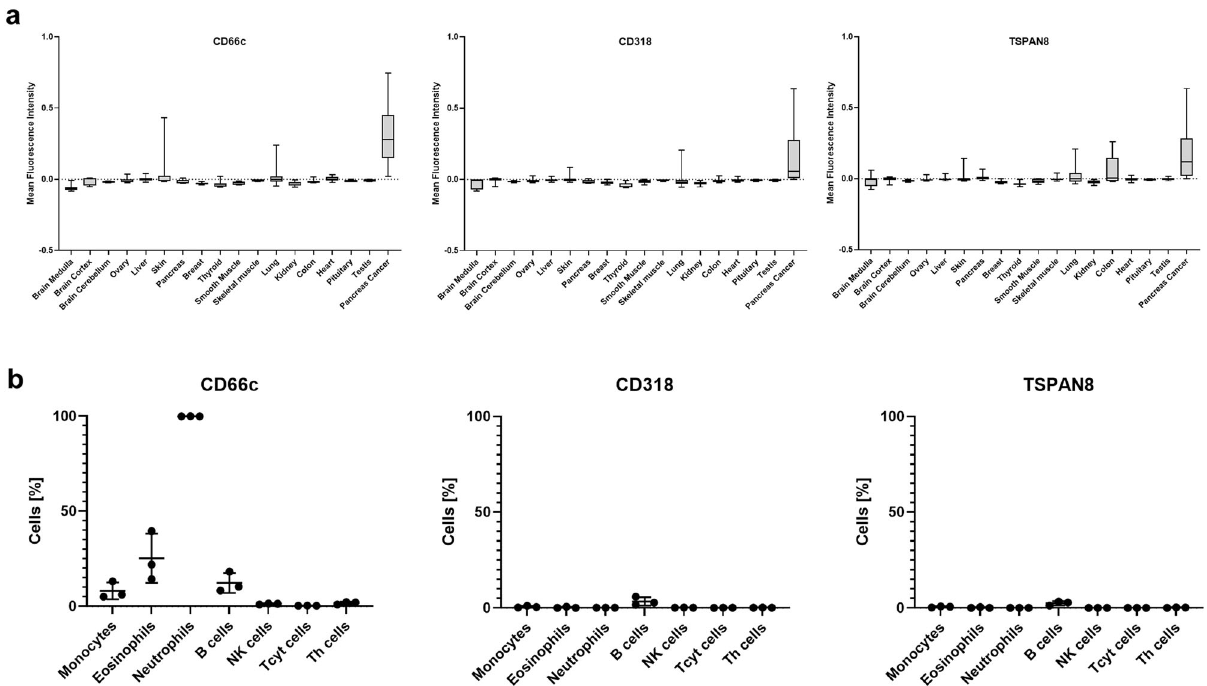
Fig. 9 Off-tumor target expression. a Quanti fi cation of target expression within different healthy tissues. Box-and-Whisker Plots show the distribution of the background corrected mean fl uorescence intensity of identi fi ed cells in the respective tissues. The lower and upper hinges in the Box-and-Whisker Plots correspond to the fi rst and third quartile (25 th and 75 th percentiles). The bar in the box depicts the median. Whiskers extend to the 5 th and 95 th percentile. CD66c: n (left to right) = 4603, 1695, 716, 6591, 5746, 13301, 8682, 1731, 13391, 4066, 5878, 2966, 2737, 10844, 11595, 7405, 3671, 3371. CD318: n (left to right) = 9341, 6542, 5282, 11438, 10593, 18148, 18395, 6578, 18238, 8913, 10725, 7813, 7584, 13933, 16442, 12252, 7112, 8218. TSPAN8: n (left to right) = 9341, 6554, 5563, 11438, 10593, 18148, 18395, 6578, 18238, 8913, 10725, 7813, 7584, 13933, 16442, 12252, 7112, 8218. b Flow cytometric analysis of target expression on lysed blood samples. Data represent mean ± SD of three donors. Source data are provided as a Source Data fi